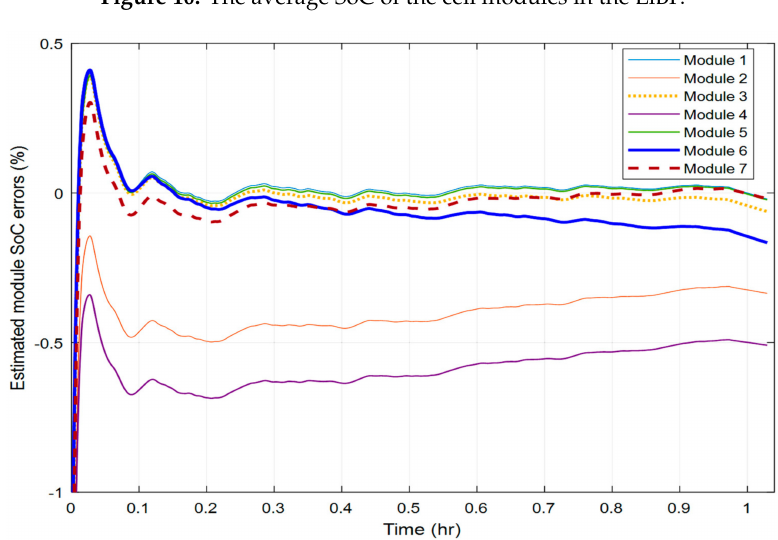
Figure 11. SoC estimation error of cell modules in the